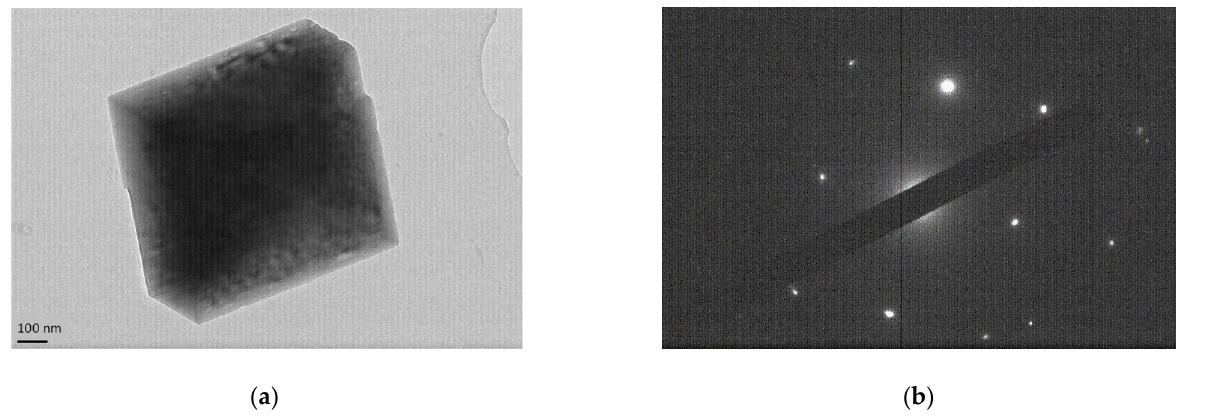
Figure 7. ( a ) TEM image of sample 01-contactor depicting a cubic single calcite particle and ( b ) the respective cubic diffraction pattern.